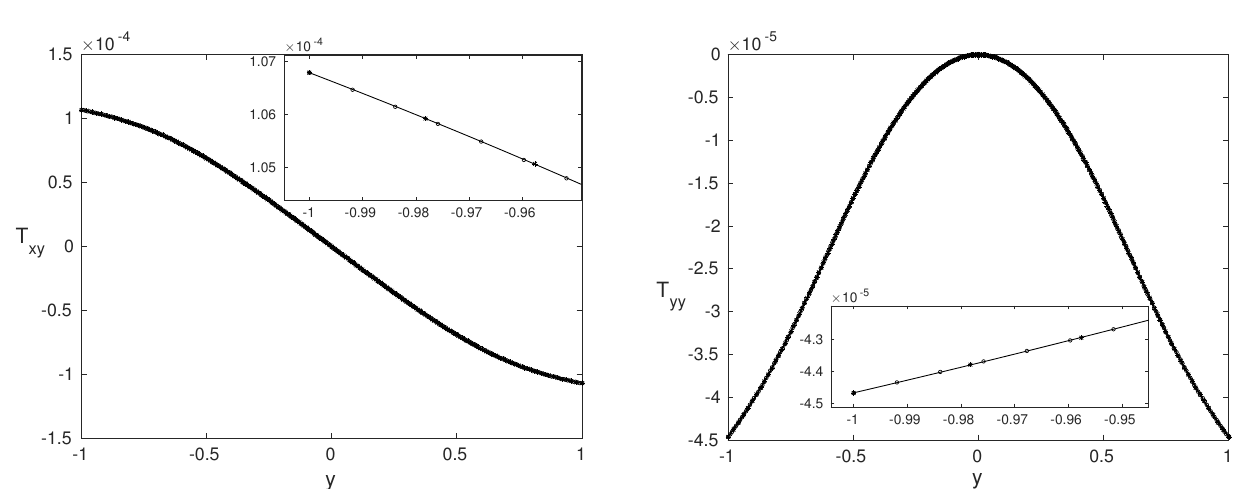
Figure 7. Same as in Figure 1 for dimensionless numbers: Re = 5000, β = 0.1, α G = 0.3 and Wi = 2.